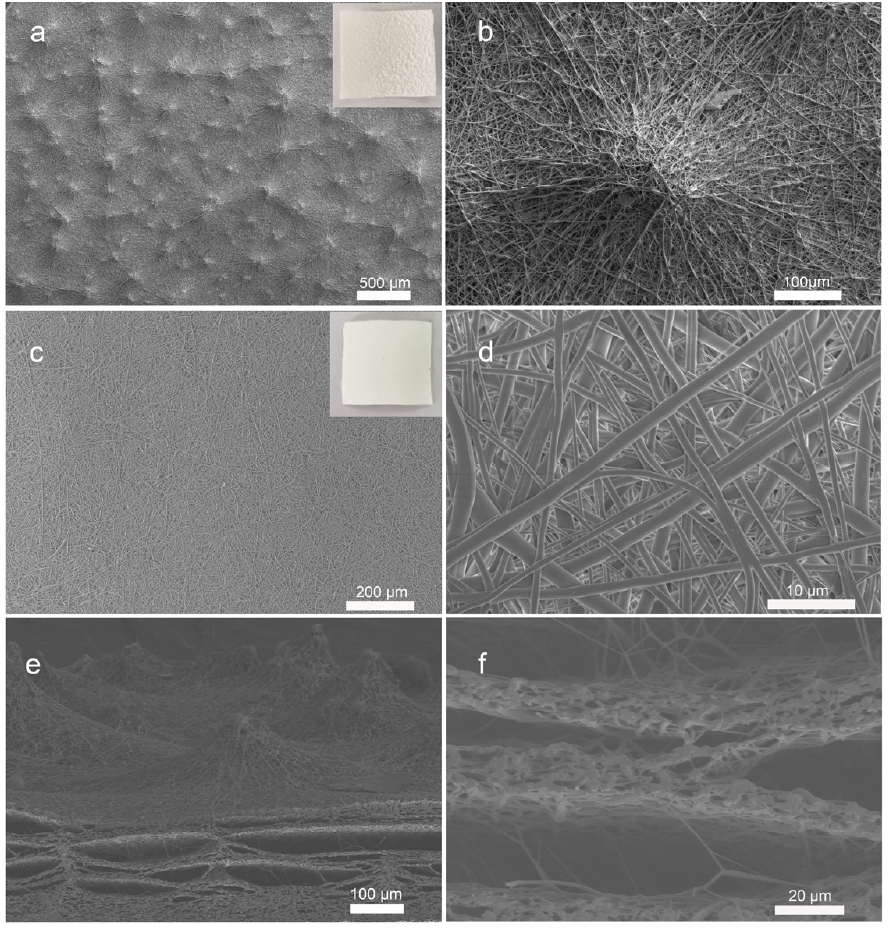
Figure 2. SEM images of the electrospun PU nanofibers film: upper surface at low magnification ( a ) and high magnification ( b ), lower surface at low magnification ( c ) and high magnification ( d ), and a cross-section at low magnification ( e ) and high magnification ( f ). The insets are photos of the upper surface and lower surface of the electrospun PU film, respectively.